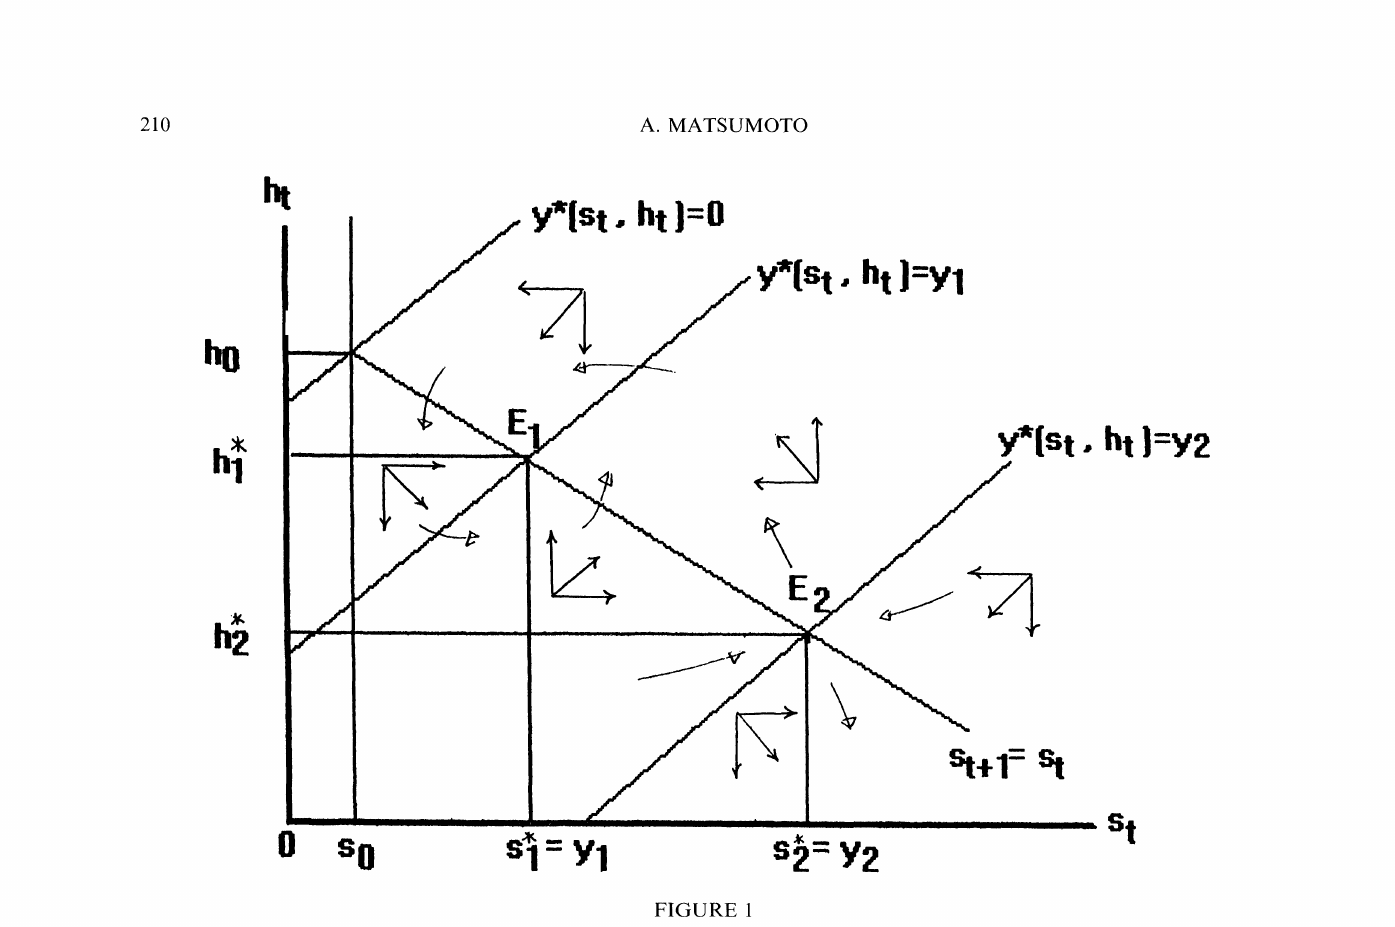
Arrows in Fig. indicate possible movements of trajectories generated by the dynamic system, (16). We can see that e equilibrium is a saddle point 2 and hence unstable except one stable path. As is seen below, the stability of el equilibrium depends on particular values of the adjustment coefficient, c, and of the inventory-expectation